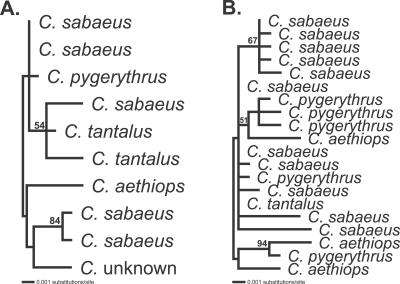
Phylogenetic Relationships among AGM Nuclear Loci(A) CD4 phylogeny and (B) CCR5 phylogeny. Both trees are midpoint rooted. ML nonparametric bootstrap support values (>50) are shown on nodes. “C. unknown” in (A) refers to a taxon with no published species-specific information.